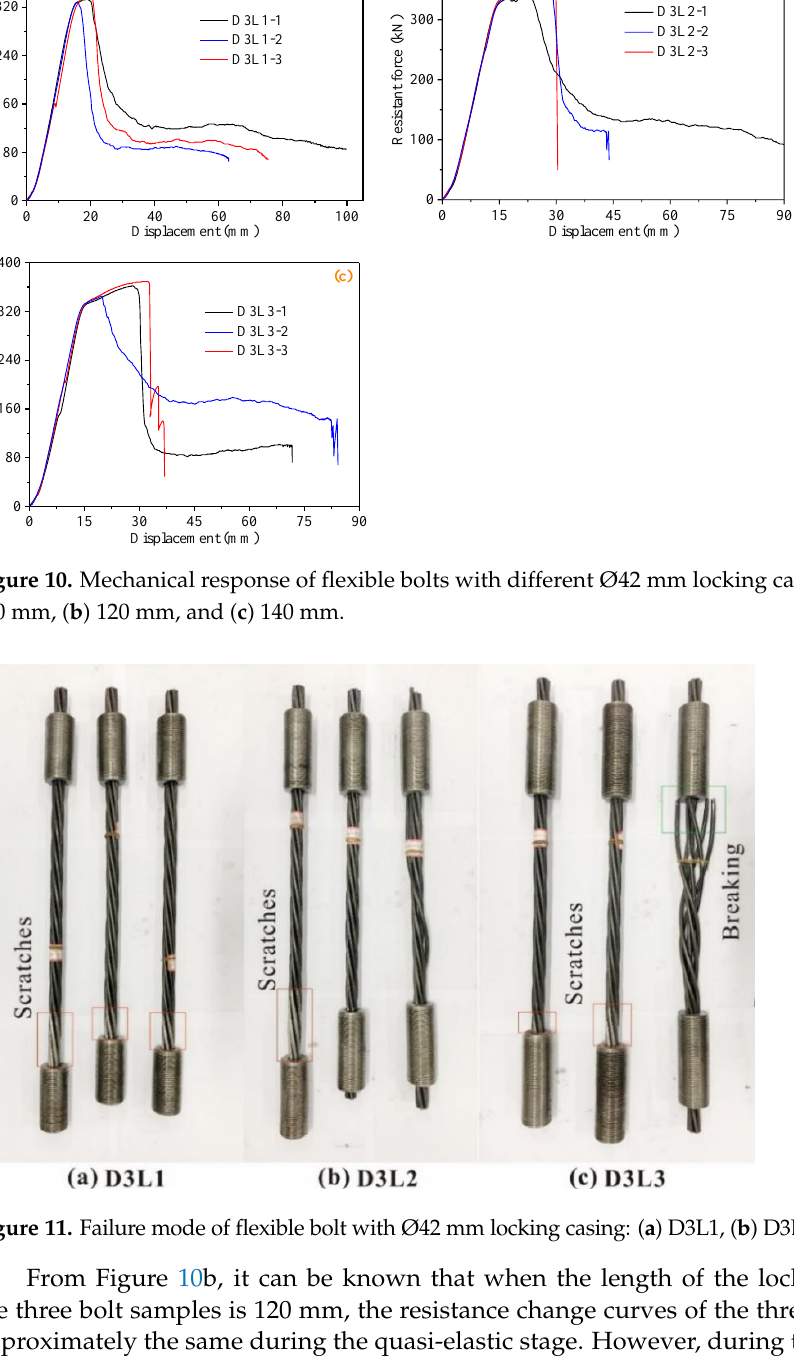
Figure 11. Failure mode of flexible bolt with Ø 42 mm locking casing: ( a ) D3L1, ( b ) D3L2, and ( c ) D3L3.